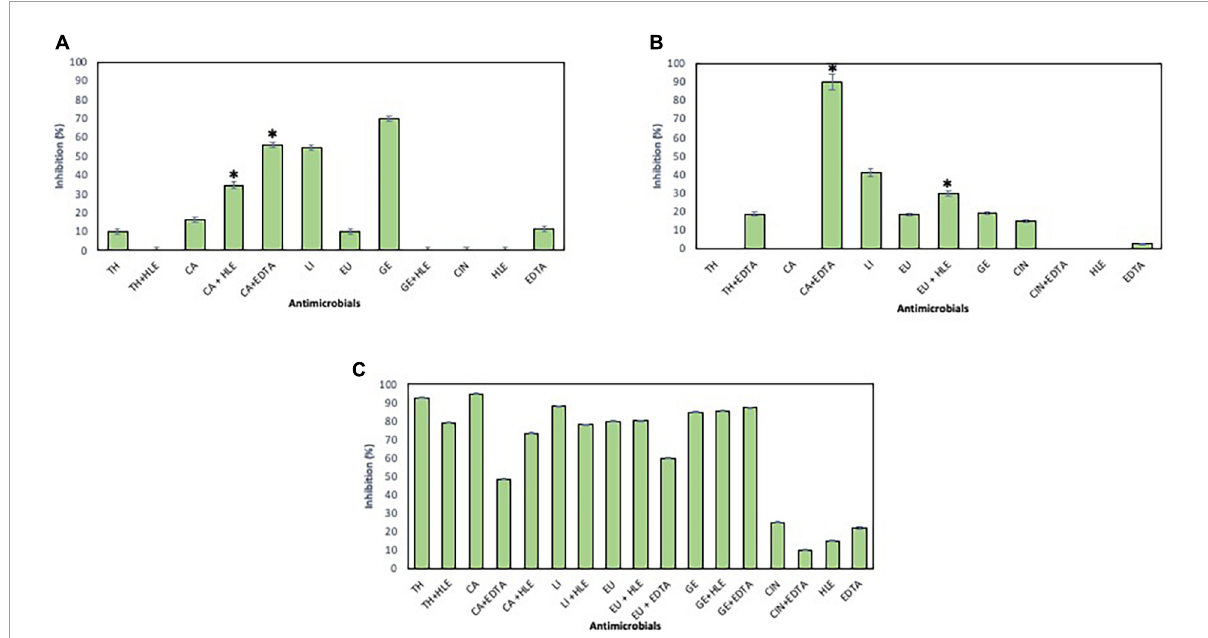
FIGURE2 Inhibition of biofilm formation of Enterococcus sp. strains M13M11 (A) , M28M11 (B) and M28M12 (C) in the presence of EOCs (TH, CA, LI, EU, GE and CIN), EDTA, HLE or their synergistic combinations at MIC and sub-MIC (0.5 or 0.25) concentrations. Data were expressed as mean value ( ± standard deviations). *Indicate a statistically significant synergistic effect of antimicrobials.